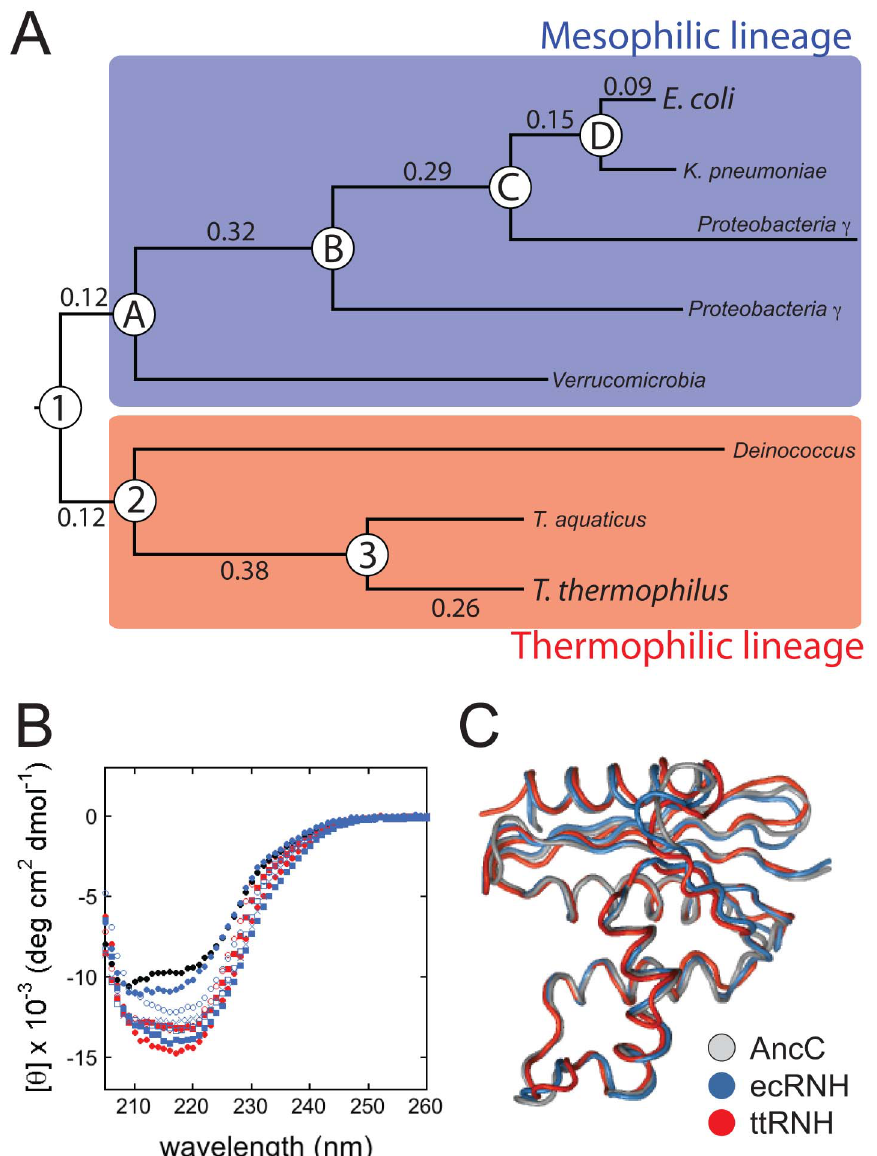
Figure 2. Reconstructed ancestral RNH proteins are functionally and structurally similar to their extant descendants. Structural characterization of ancestral RNH proteins indicates they adopt the canonical RNH fold and closely resemble their extant descendants. (A) Simplified phylogram of the RNH tree indicating positions of resurrected ancestors. Branches on the tree are labeled with their lengths measured in average number of substitutions per site (see Figure S2). (B) CD spectra of ecRNH (blue solid circles), ttRNH (red solid circles), Anc1 (black solid circles), ancestors from the mesophilic lineage (AncA, blue Xs; AncB, blue open squares; AncC, blue solid squares; AncD, blue open circles), and ancestors from the thermophilic lineage (Anc2, red solid squares; Anc3, red open circles) at 25 u C in 20 mM NaOAc (pH 5.5), 50 mM KCl, and 1 mM TCEP (see Dataset S2). (C) Superposition of AncC (grey; PDB ID: 4LY7) with ecRNH (blue; PDB ID: 2RN2) and ttRNH (red; PDB ID: 1RIL) for residues 3-145. See also Table S3. doi:10.1371/journal.pbio.1001994.g002 This equation defines the temperature-dependent relationship protein stability curve for each ancestor (Figure S4). This curve, a between the global stability of a protein ( D G unf ) and three key plot of D G unf against temperature, can be determined by performing chemical denaturation experiments across a wide thermodynamic parameters: the temperature of maximum stabil- range of temperatures. It exhibits a characteristic parabolic shape ity ( T s ), the change in enthalpy upon unfolding at T s ( D H s ), and the that is described by the Gibbs-Helmholtz equation: change in heat capacity upon unfolding ( D C p ). The T m , or thermal melting temperature, is the right-most x -intercept of this curve. By fitting the parameters of the equation to our data, we can extract detailed thermodynamic and mechanistic information about each